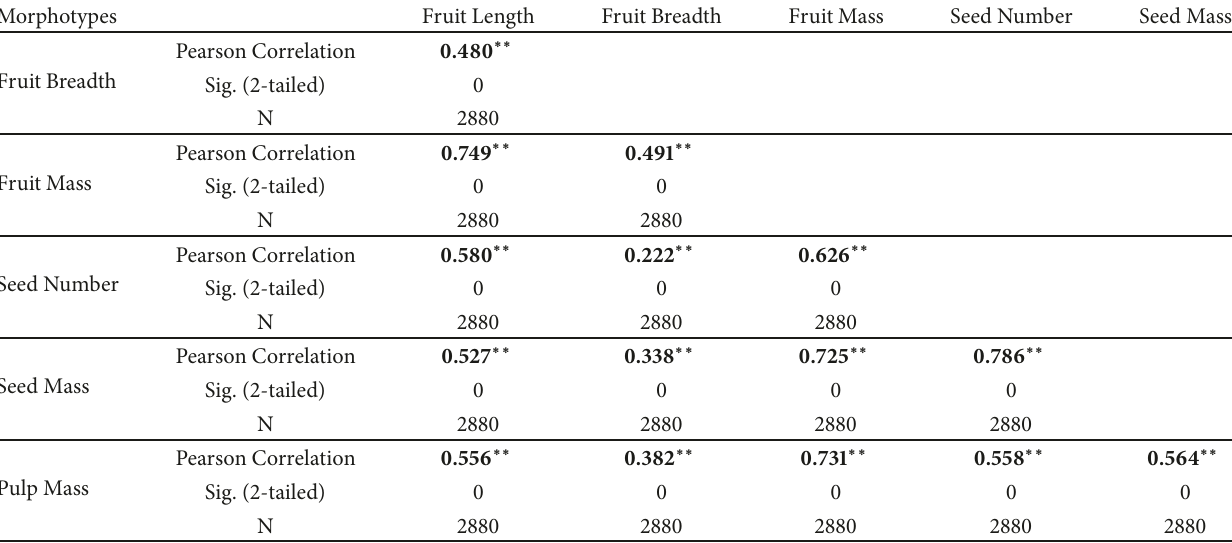
Table 3: Pearson coefficient (R) of correlation between T. indica morphological traits.